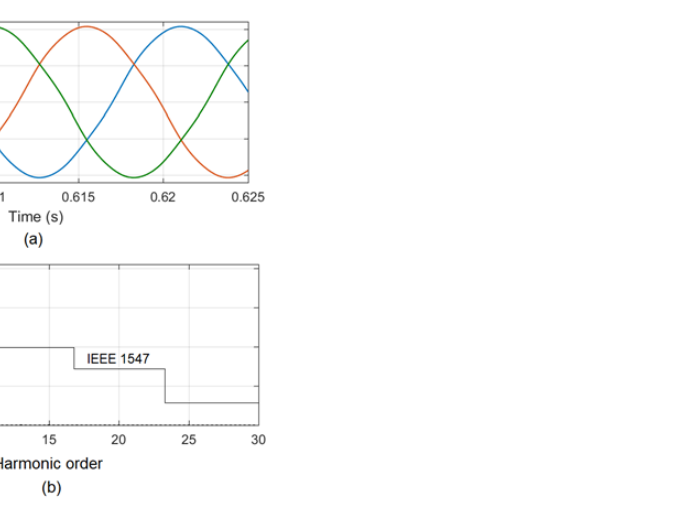
Figure 8. Three-phase grid current waveform and the respective harmonic spectra during distorted grid voltage and with L gmin . for the proposed controller.